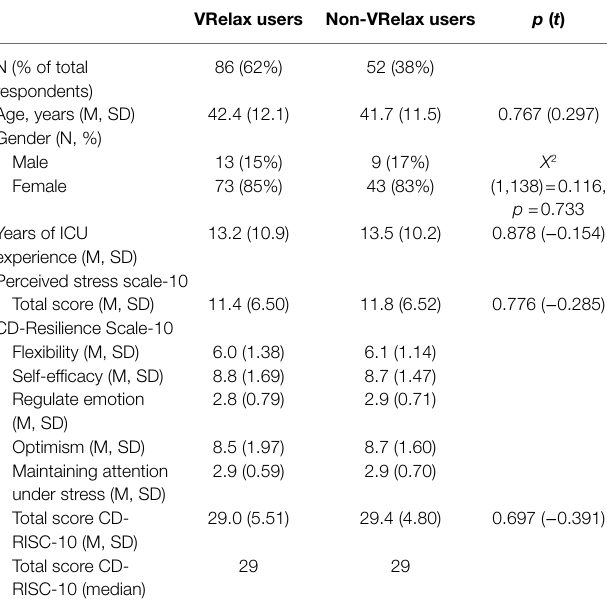
TABLE 1 | Descriptive statistics of ICU nurses, VRelax users, and non-VRelax users. VRelax users Non-VRelax